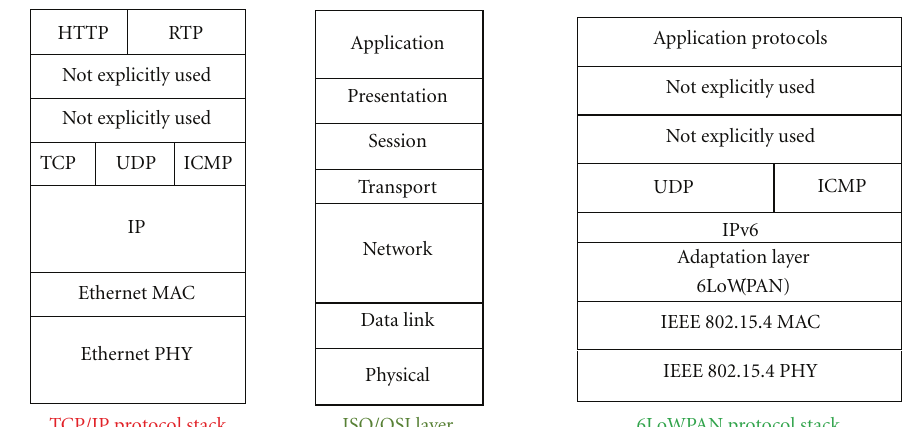
Figure 1: Architecture of 6LoWPAN [7].